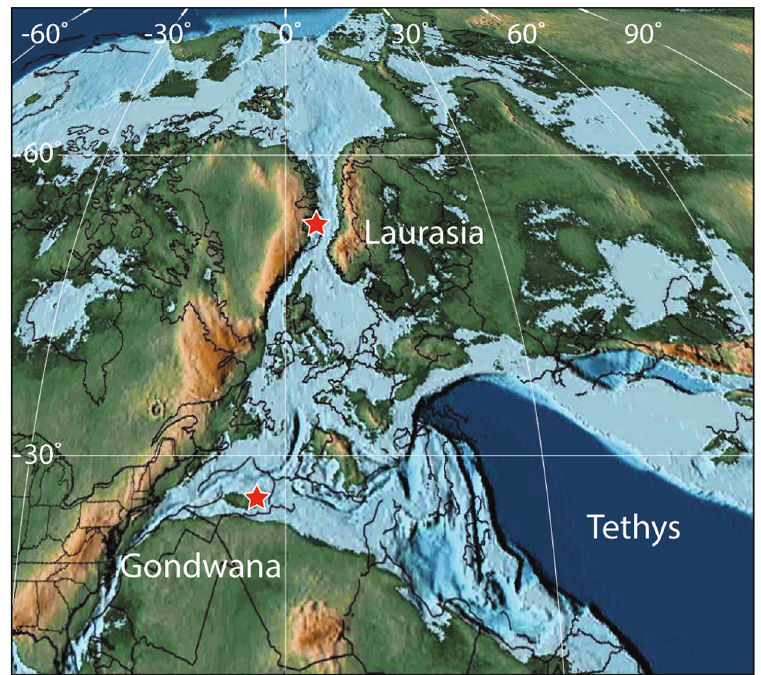
Figure 1. Early Jurassic paleogeographic map of the western Tethys (after ref. 96 ) showing the location of the Central High Atlas Basin along the northern Gondwana margin and Jameson Land along the East Greenland margin. Maps generated with Adobe Illustrator CC 2015,